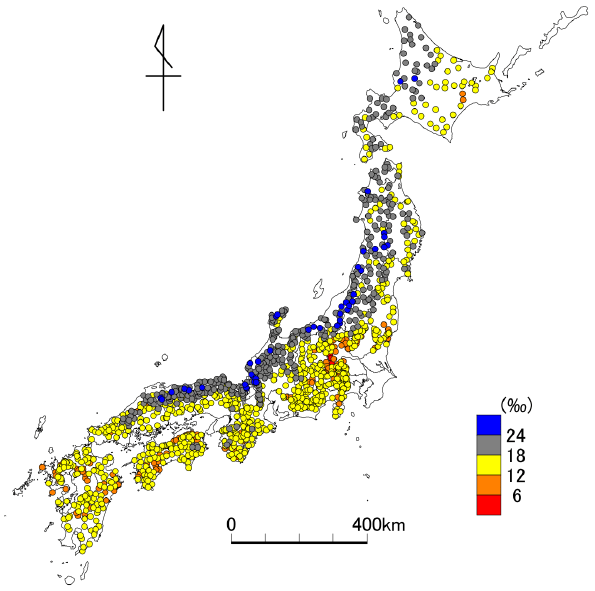
Figure 5. Spatial distribution of d-excess values in stream water.